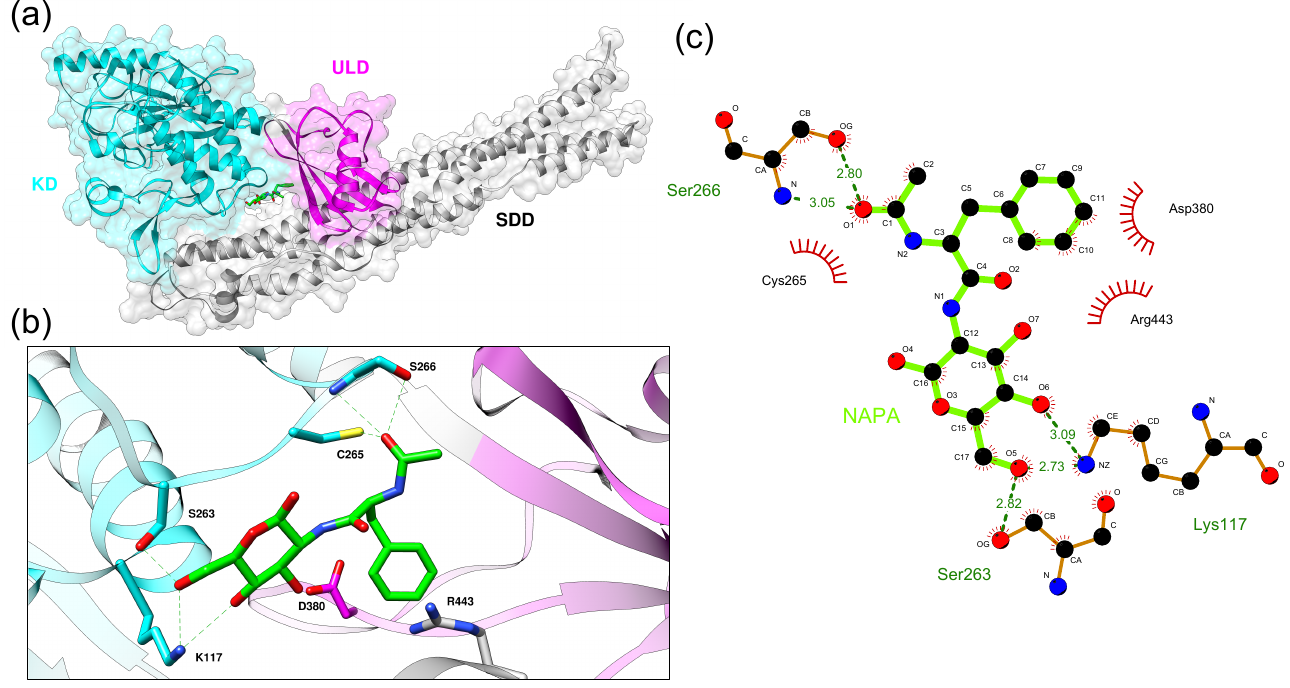
Figure 7. Representative structural model of the IKK α -NAPA complex after MD simulation refinement. ( a ) IKK α is depicted as cartoon. NAPA molecule is represented in stick model (green). KD, ULD, and SDD domains are colored in cyan, magenta, and gray, respectively. ( b ) Interacting residues are represented in stick model. Dashed red lines indicate hydrogen bonds. ( c ) IKK α -NAPA non-covalent interactions. Dashed green lines indicate hydrogen bonds, red lines indicate hydrophobic